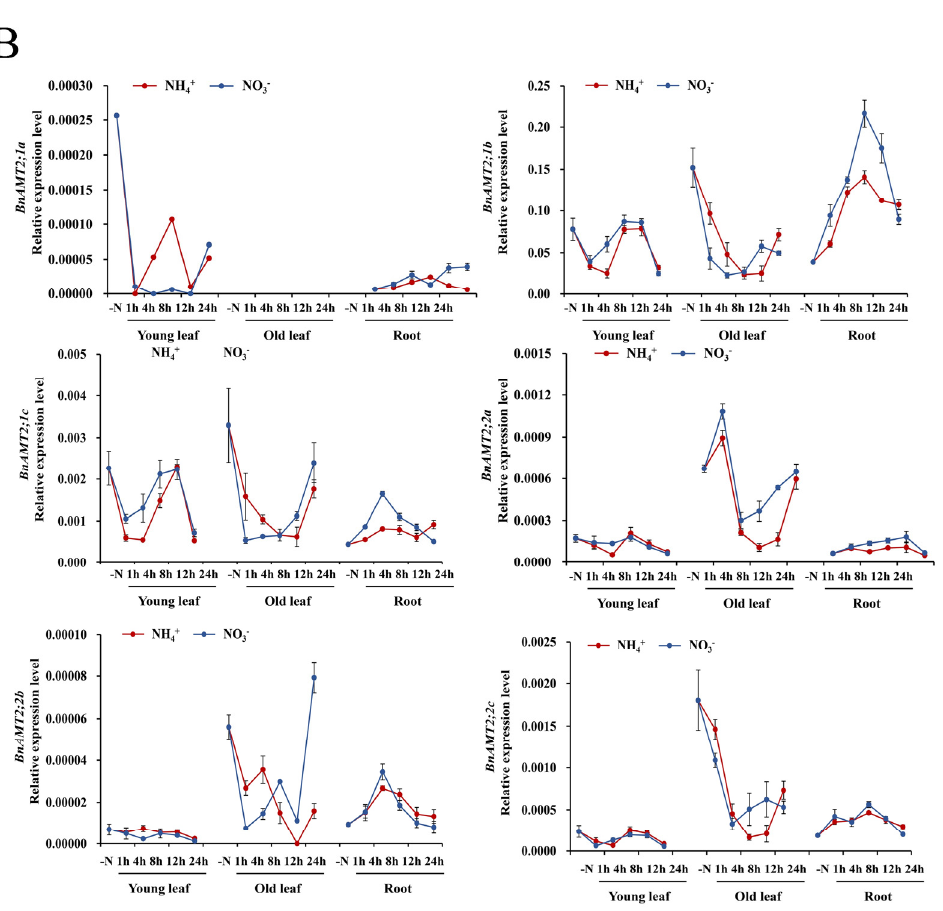
Figure 4. The expression profiles of BnaAMTs in different tissues of rapeseed with ammonium and nitrate supply. ( A ) BnaAMT1s ; ( B ) BnaAMT2s . The red lines indicate ammonium source, while blue lines indicate nitrate. Rapeseed young leaves, old leaves, and roots were separately collected at 1 h, 4 h, 8 h, 12 h, and 24 h after resupplying N-deficient rapeseed plants with NH 4+ or NO 3 − . Samples were stored at − 80 °C for RNA extraction and qRT-PCR analysis. The relative expression levels of BnaAMTs were relative to the control ( actin 7 ). Four biological replicates were performed. Error bars represent standard deviation.